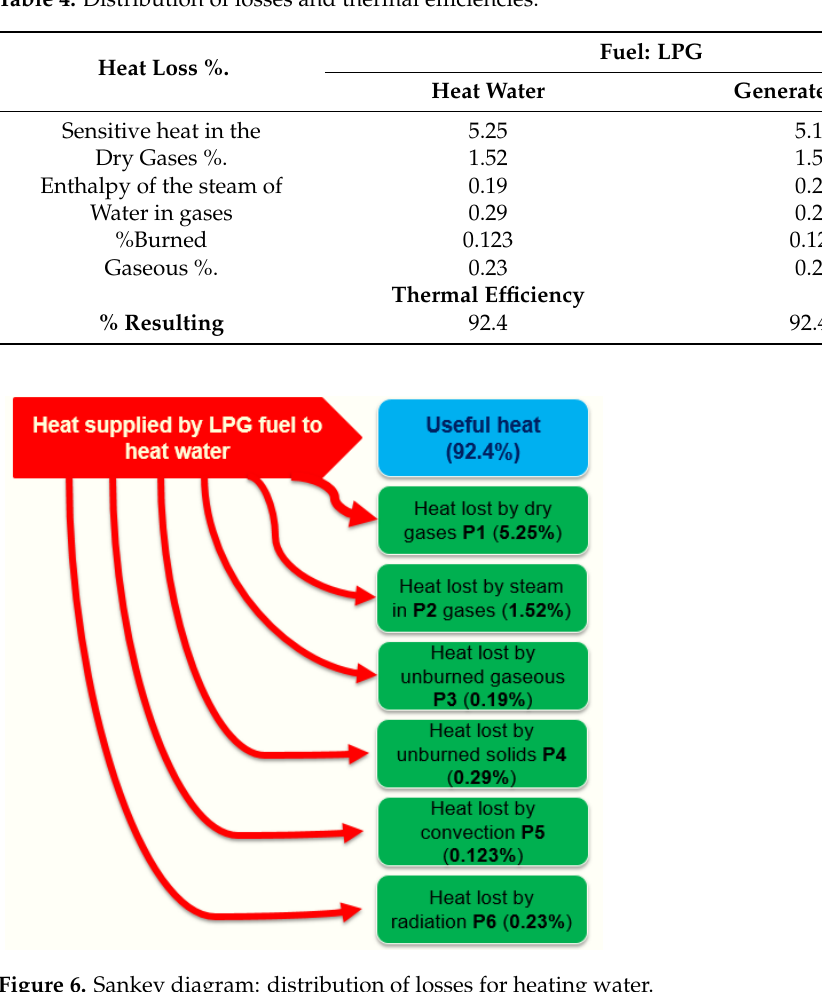
Table 4. Distribution of losses and thermal efficiencies.